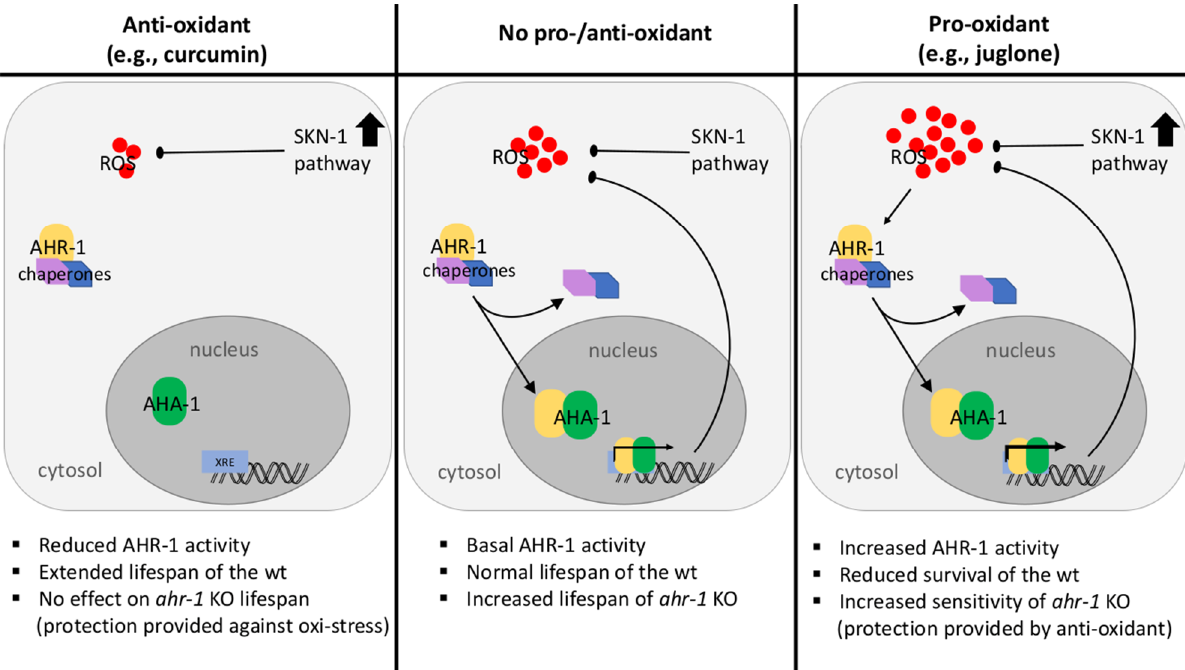
Figure 7. Proposed model of the AHR-1 signaling pathway in C. elegans response to pro- and antioxidants. In “normal” conditions (middle panel), AHR-1 is activated by intra-cellular ROS. This leads to the shedding of the chaperones from cytosolic AHR-1 and the subsequent nuclear translocation of AHR-1. In the nucleus, AHR-1 forms a heterodimer with the AHR nuclear translocator (AHA-1) and bind to XREs of target genes, which in turn leads to the reduction in intracellular ROS levels. In these conditions, loss of ahr-1 function leads to an increased lifespan. In the presence of antioxidants (left panel) the intra-cellular ROS concentrations are low leading to AHR-1 residing in the cytoplasm, bound by its cofactors. The inhibition of the basal AHR-1 activity leads to an increased lifespan. In the presence of pro-oxidants (right panel) AHR-1 is activated by excessive ROS, which results its nuclear translocation, the AHR-1–AHA-1 heterodimer formation and the initiation of target gene transcription. In the ahr-1 KO, the decreased detoxification of ROS through AHR-1-induced target genes leads to an accumulation of ROS and renders the ahr-1 KO